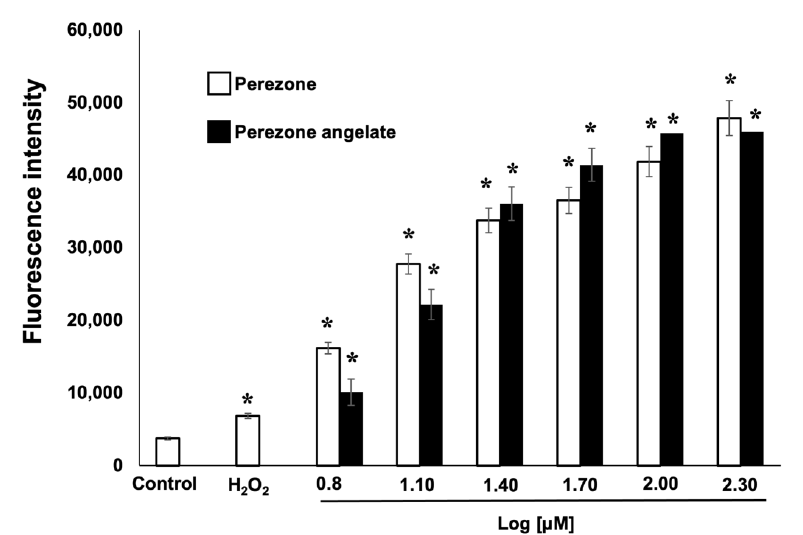
Figure 6. ROS production in U373 cells treated for 48 h with increasing perezone and perezone angelate concentrations evidenced by flow cytometry analysis of DCFH-DA staining ( n = 3). Bars represent mean ± SEM. Statistical differences were calculated by one-way ANOVA, and Tukey’s post hoc test, * p < 0.05 (between control and treatments).